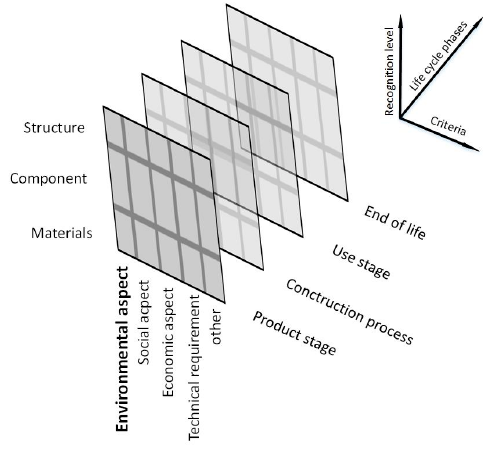
Figure 1. 3D model of an ILCD [38].